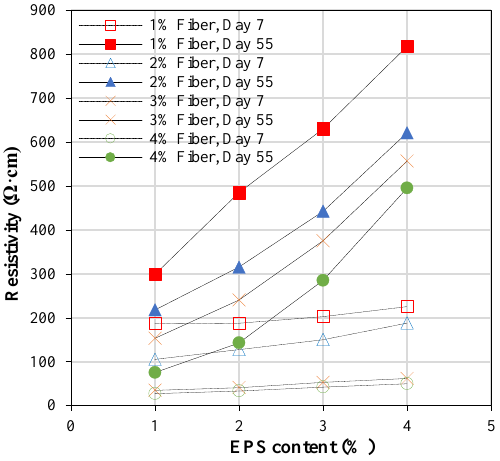
Figure 5. The resistivity of specimens with curing period of 7 and 55 days.